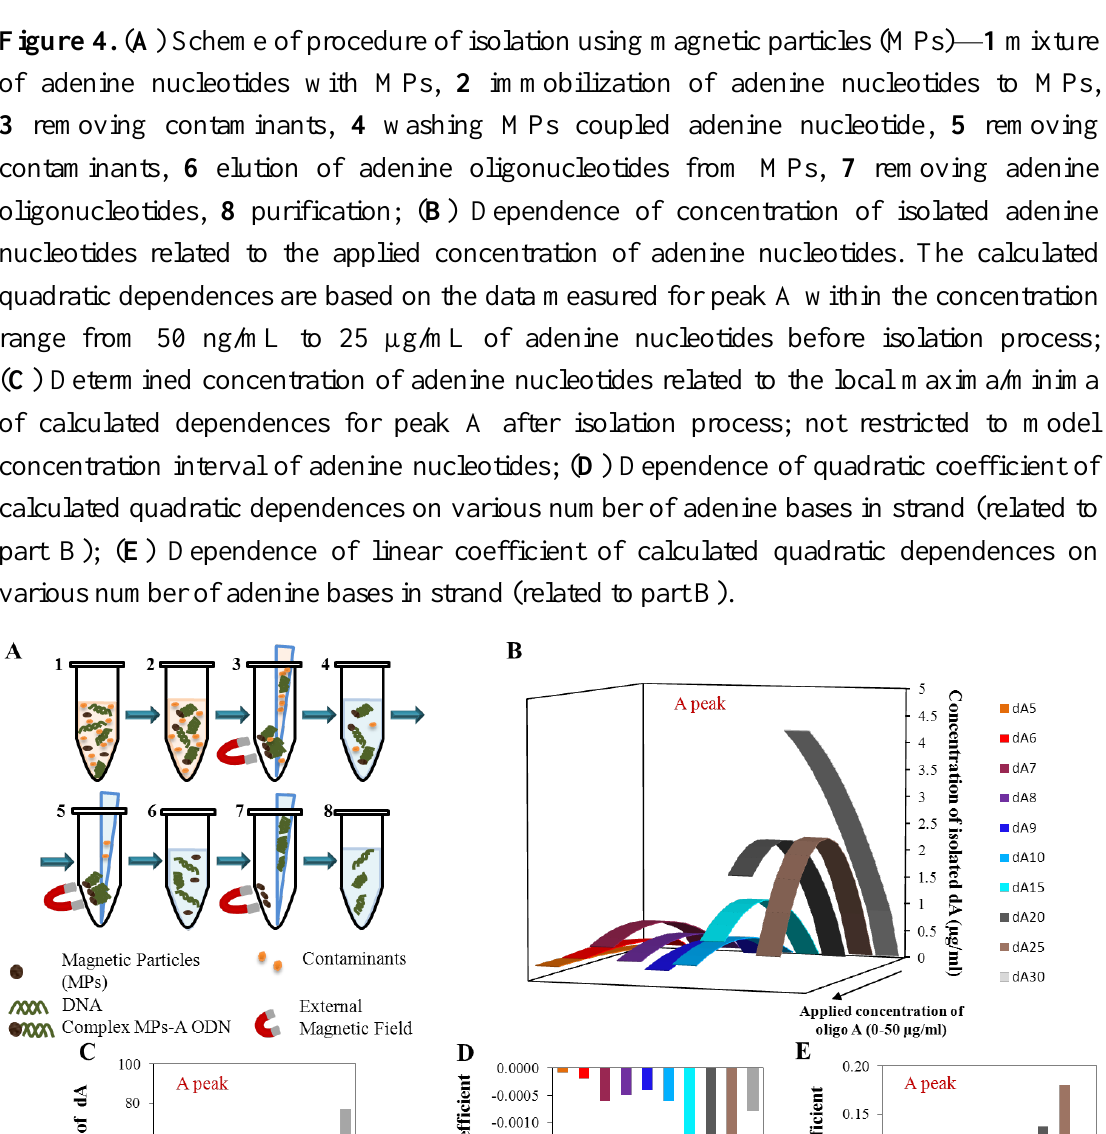
Figure 4. ( A ) Scheme of procedure of isolation using magnetic particles (MPs)— 1